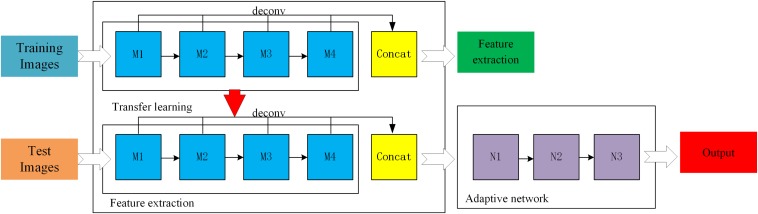
A general scheme of the Improved ResNet.